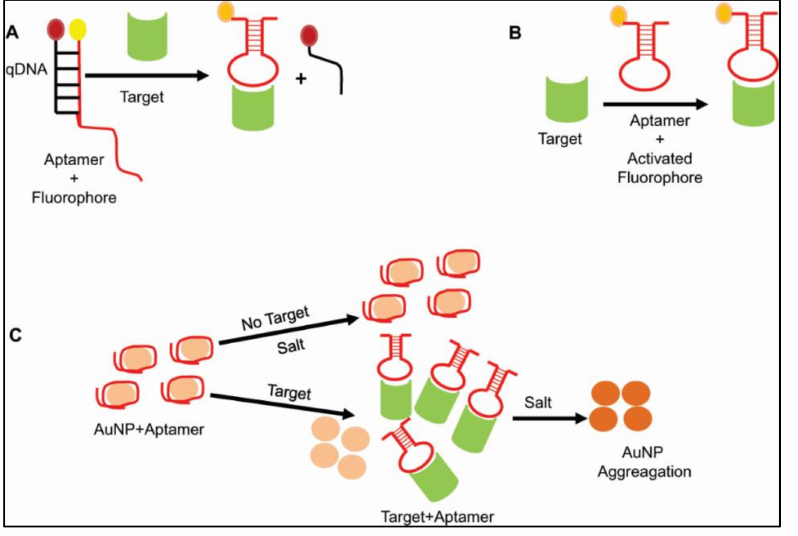
Figure 1. Schematic representation of aptamer-mediated detections. ( A ) Target-induced structural conversion mode: The fluorophore-tagged aptamer binds with a short oligonucleotide sequence having a quencher molecule by base pair complementarity. In the absence of a target molecule, the quencher molecule quenches fluorophore. Upon target binding, the conformational change in the aptamer helps to release qDNA and finally fluoresce. ( B ) Direct binding-based mode: The fluorophore-tagged aptamer directly binds with target. ( C ) Target-induced dissociation mode: Gold nanoparticles (AuNP) are coated onto the aptamers. Salt-mediated aggregation of AuNPs after the aptamer–target interaction finally leads to target detection by a colorimetric